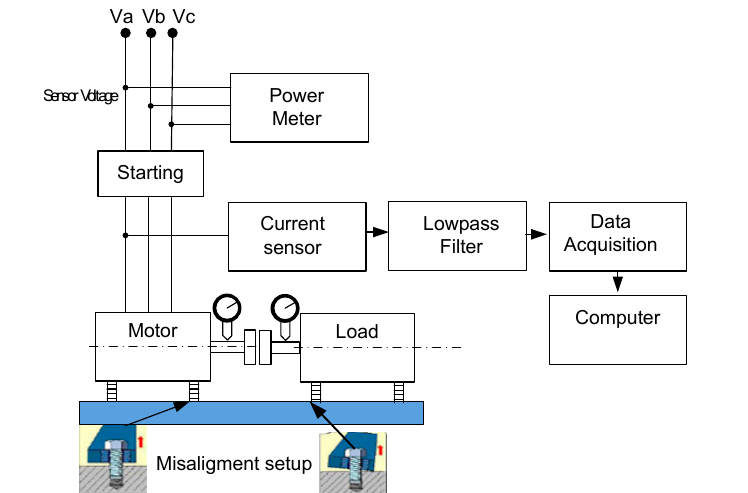
Figure 4. Testing diagram of the induction motor and equipment for data recording.